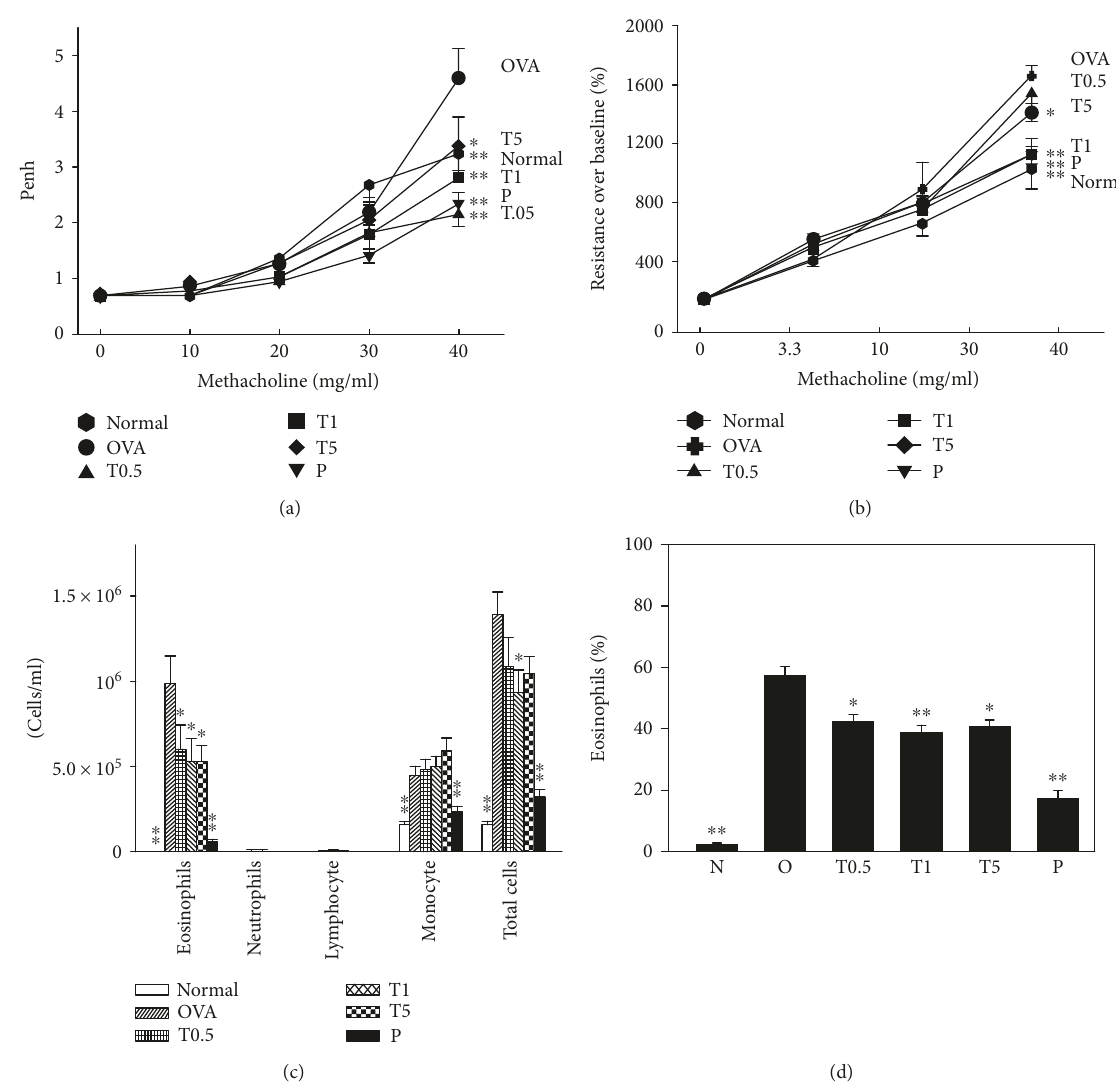
Figure 1: Tomatidine reduces airway hyperresponsiveness (AHR) in asthmatic mice. (a) Mice inhaled increasing doses of methacholine, and AHR was assessed and shown as Penh values. n = 12 mice/group in three independent experiments. (b) AHR was measured as a percentage from the baseline level of lung resistance. E ff ect of tomatidine on cell counts in bronchoalveolar lavage fl uid (BALF) from asthmatic mice. (c) In fl ammatory cells and total cells were counted in BALF. (d) Eosinophil percentages were measured in BALF. All data are presented as means ± SEM. ∗ P < 0 05 , ∗∗ P < 0 01 compared to the OVA control